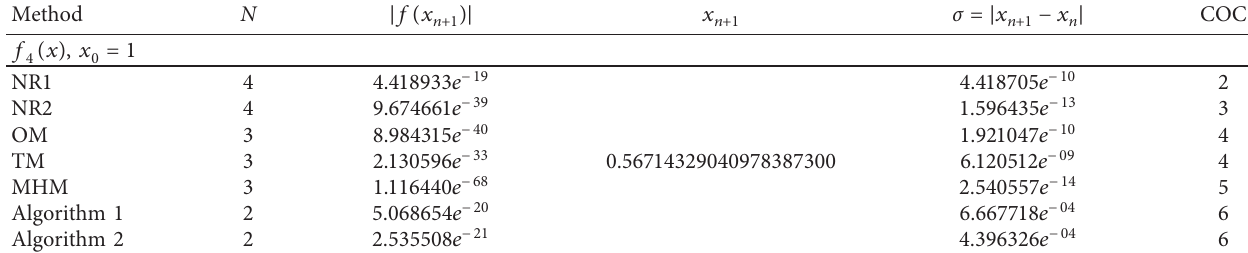
Table 4: Comparison of various iterative methods.